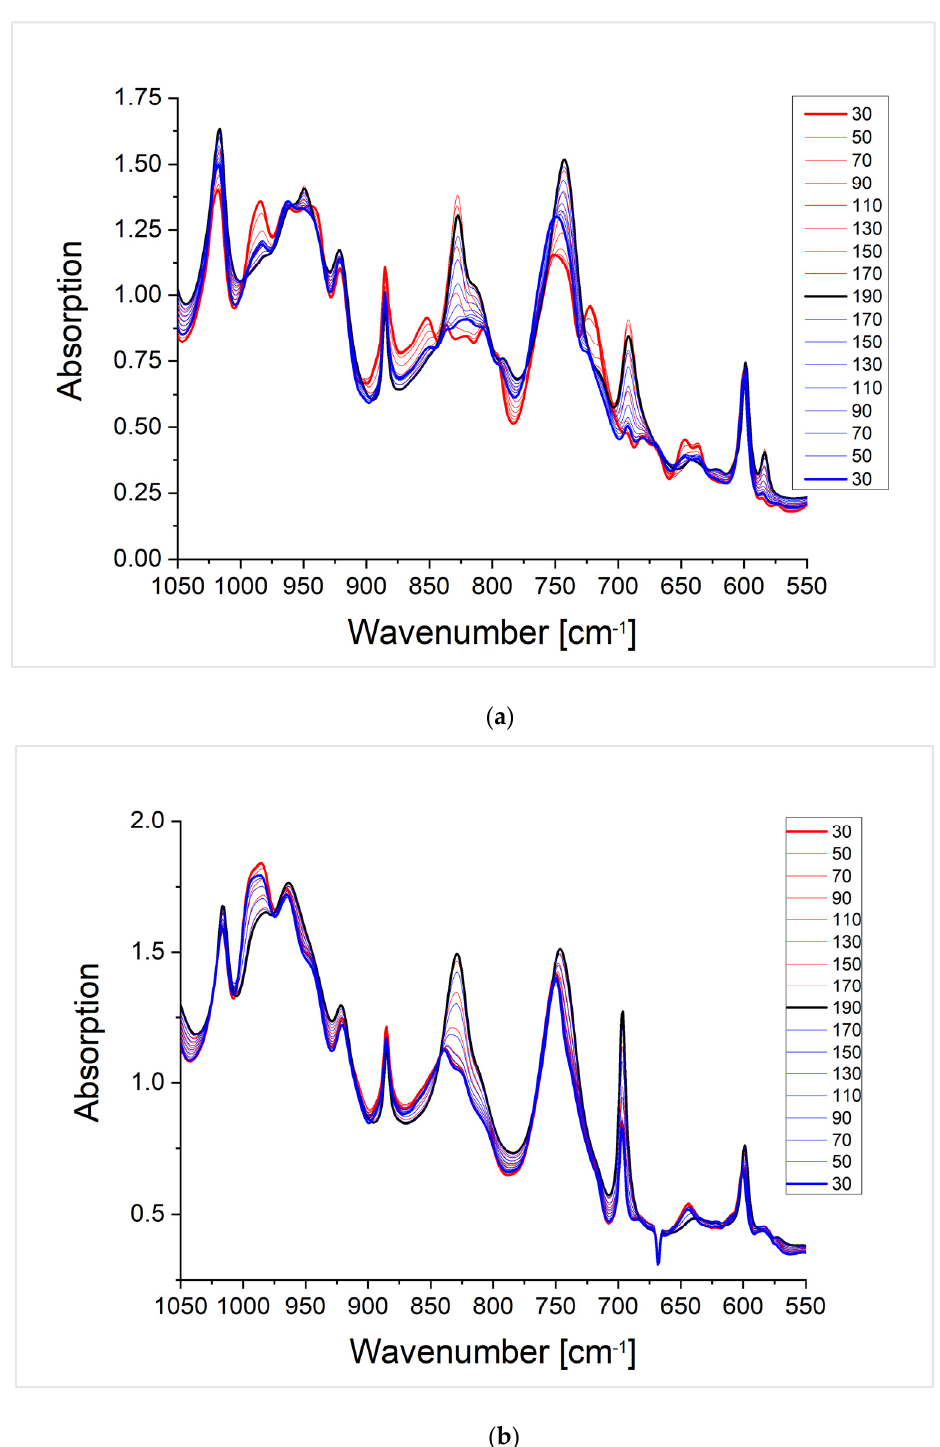
Figure 9. DSC heating (red) and cooling (blue) curves of the c rosslinked P(BA 60 - co -FMA 40 ) 10 . ( a ) Crosslinked P(BA 60 - co -FMA 40 ) 10 with BMI in a motif ratio of 1:1. The endothermic peak indicates the retro-Diels-Alder reaction at around 90 °C in all three heating curves. ( b ) Crosslinked P(BA 60 - co -FMA 40 ) 10 with P(MMA 74 - co -MIMA 26 ) 9 . The endothermic peak indicates the retro-Diels-Alder reaction starting at around 100 °C in the third and fourth heating curve.